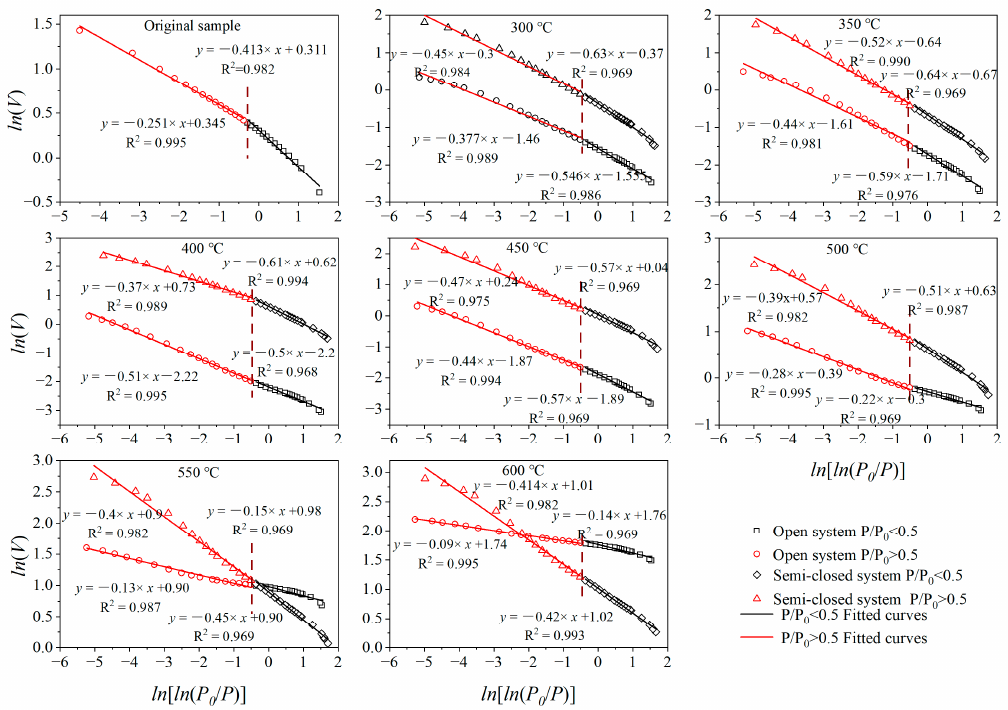
Figure 12. Plots of ln ( V ) versus ln [ ln ( P0/P )] from low-temperature nitrogen physisorption isotherm data using the open system and semi-closed system pyrolysis experiments. Data of semi-closed pyrolysis are cited from Fang et al. [21].